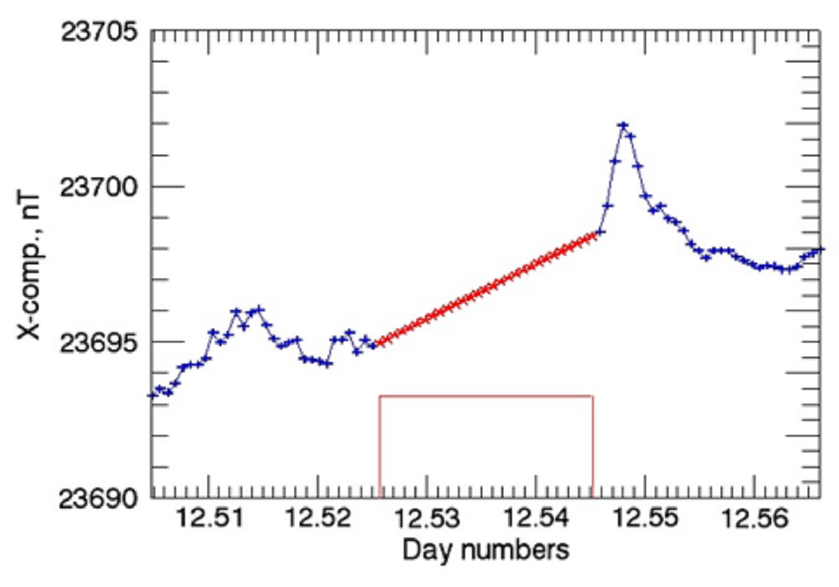
Fig.2. The figure demonstrates the procedure for the gape removal. One gape, observed at the day 13 (20.02.2017) of the time interval is marked by the bar plot. The original data are presented by plusses, connected by lines, and the interpolated data are shown by asterisks, also connected with a line. The sequence of days begins with number one for